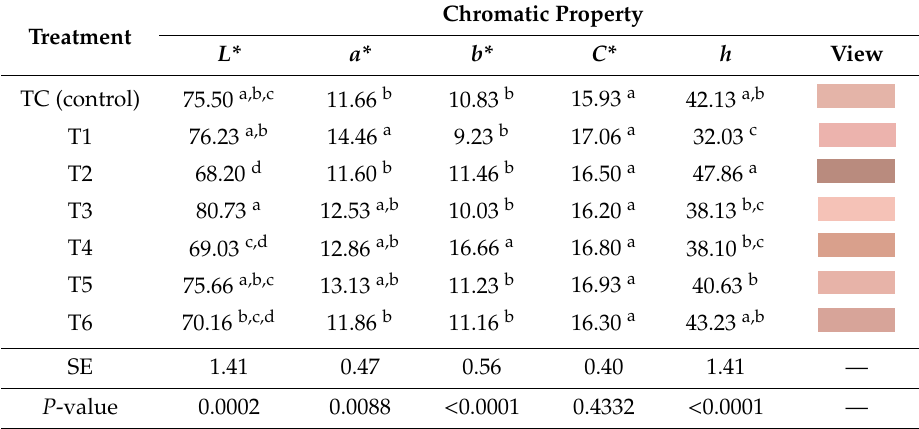
Table 2. Chromatic properties of frankfurter sausages treatments.